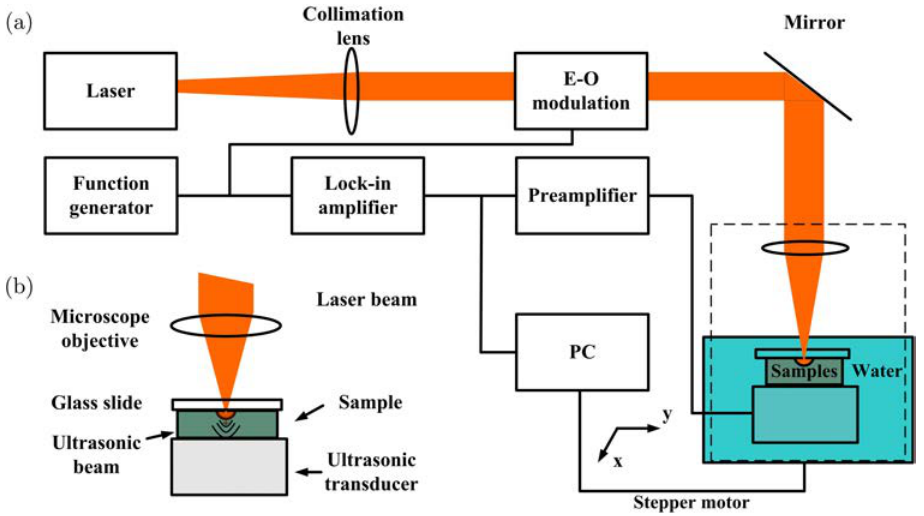
Fig. 1. (a) Scheme of experimental setup for PAVEI. (b) The speci¯c structure indicated by the dashed